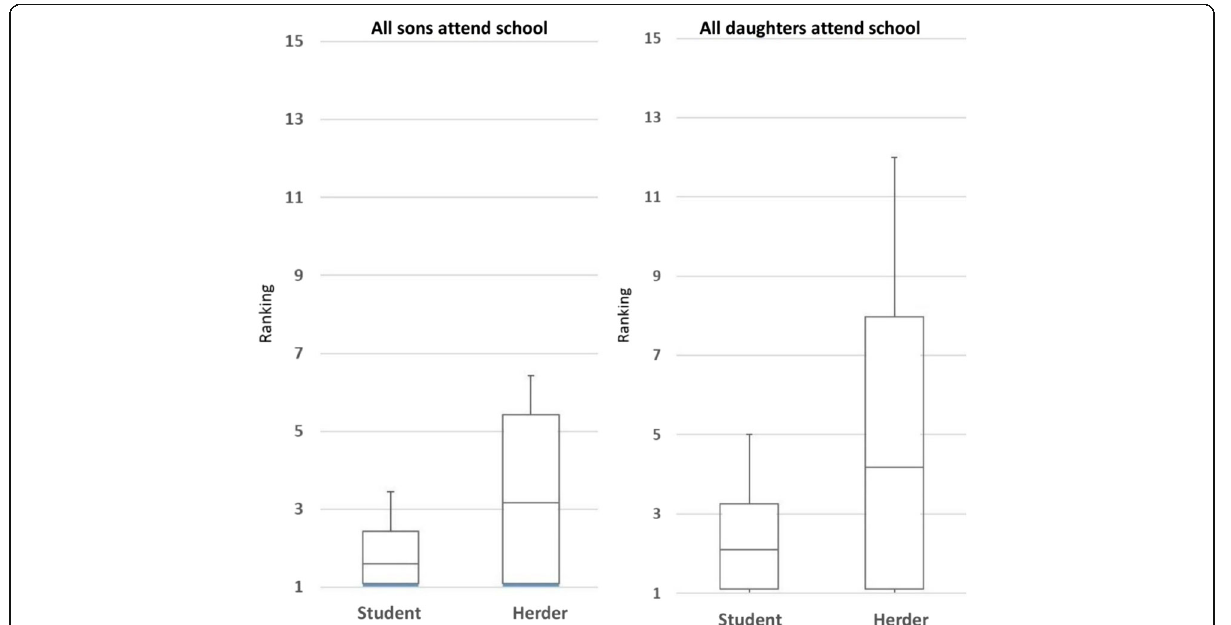
Figure 2 Boxplot of student and herder rankings of sons & daughters attending